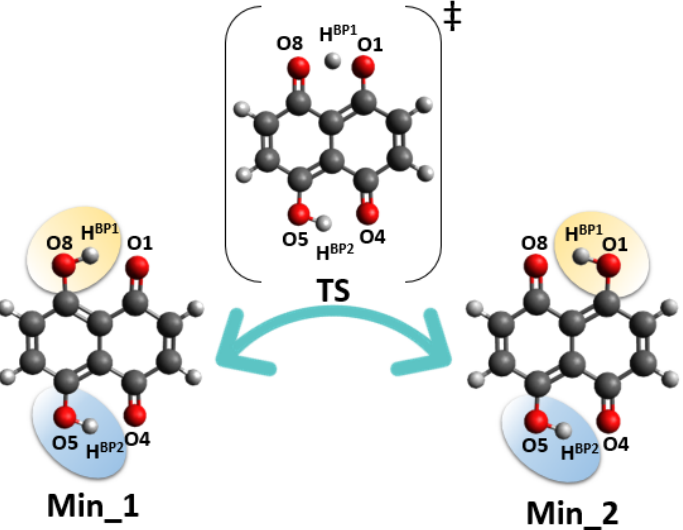
Figure 3. Proton transfer reaction model of Naphtazarin. Min_1—C 2 v energy minimum with the plane symmetry; Min_2—C 2 h energy minimum; TS—transition